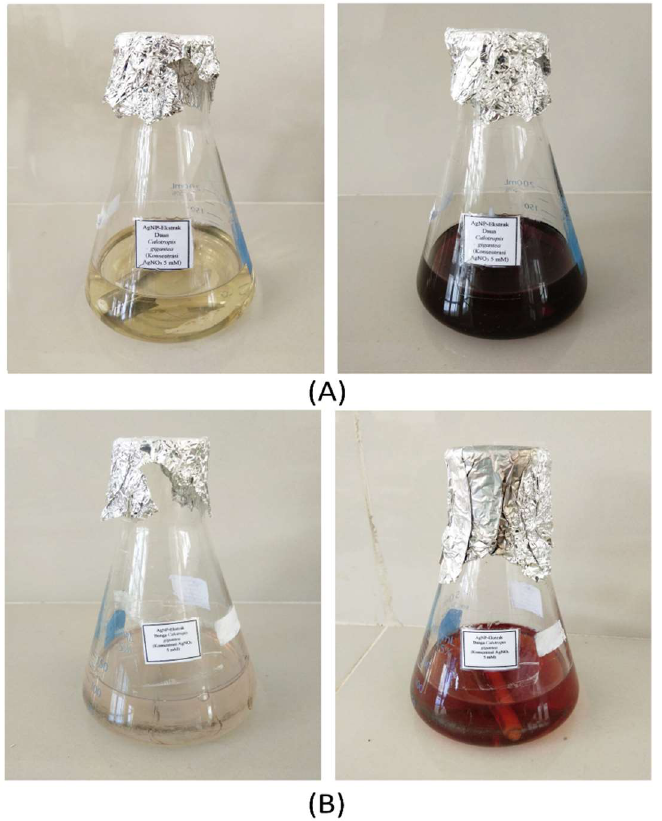
Figure 1. Visual appearance of AgNO 3 solution mixed with leaves ( A ) and flower extract ( B ) from geothermal C. gigantea before (left) and after (right) the dark incubation.